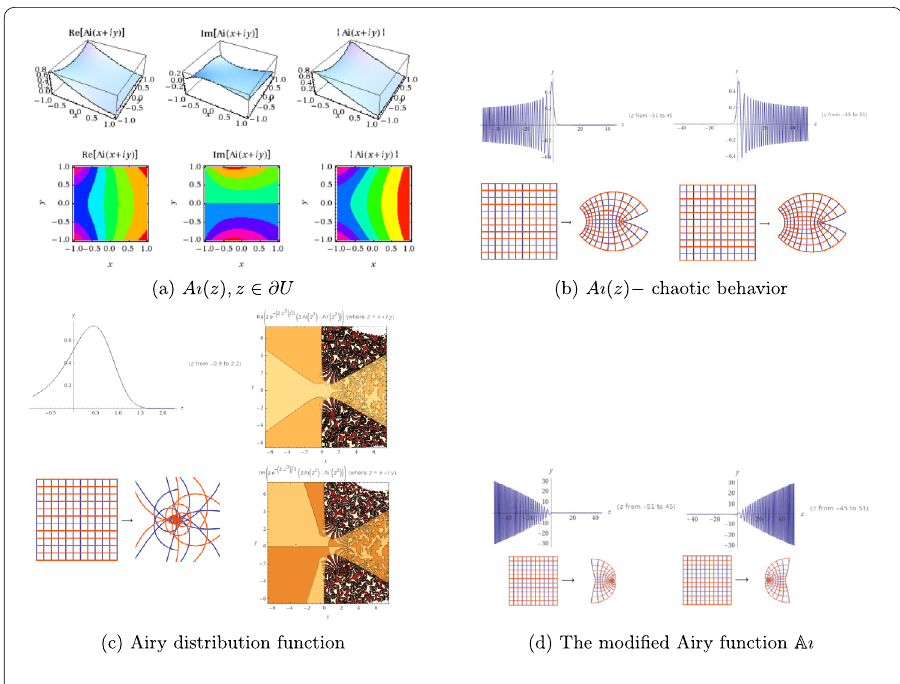
Figure 1 Three behavior graphs of Airy A ı ( z ) and Airy distribution functions respectively